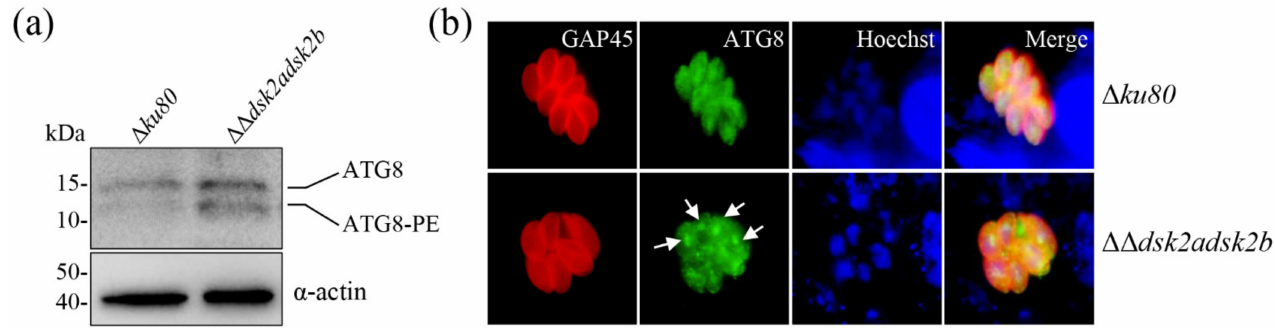
Figure 7. Autophagy pathway occurred in DSK2s mutant strain. ( a ) Western blotting detected ATG8 and ATG8-PE in ∆∆ dsk2adsk2b and ∆ ku80 . ATG8 was detected by mouse anti-ubiquitin polyclonal antibody (upper panel). Actin served as a loading control (bottom panel). ( b ) IFA detected ATG8 in ∆∆ dsk2adsk2b and ∆ ku80 . Parasites were labeled with mouse anti-ATG8 polyclonal antibody (green) and rabbit anti-TgGAP45 (red). Arrow indicates the aggregated ATG8. Hoechst was used to stain the nuclei (blue). Scale bar: 2.5 µ